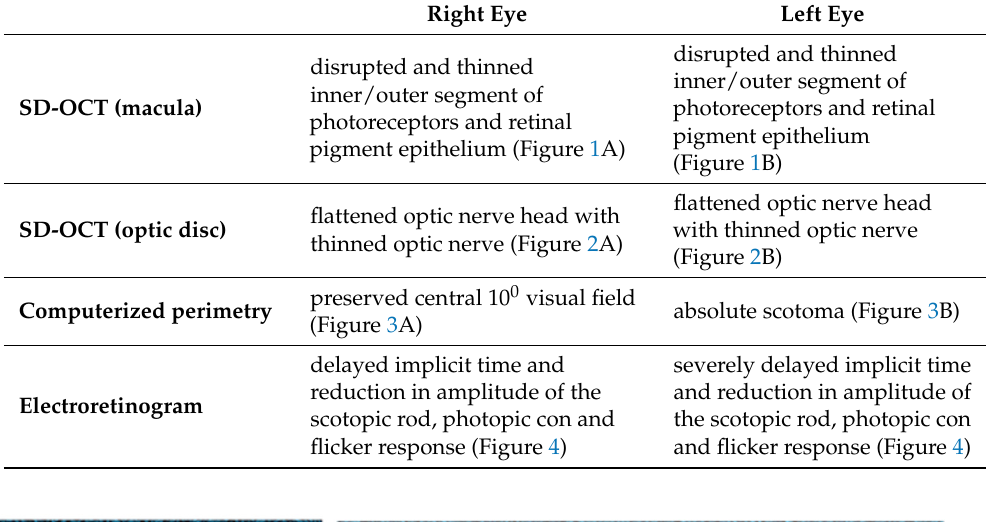
Table 2. Ophthalmological diagnostic tests.